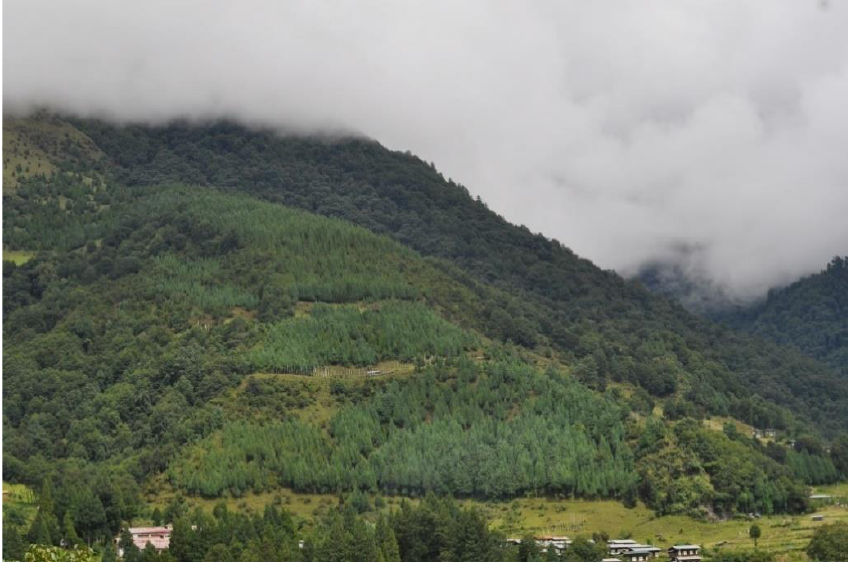
Figure 2. Community plantations in Trashigang dzongkhag , Eastern Bhutan.